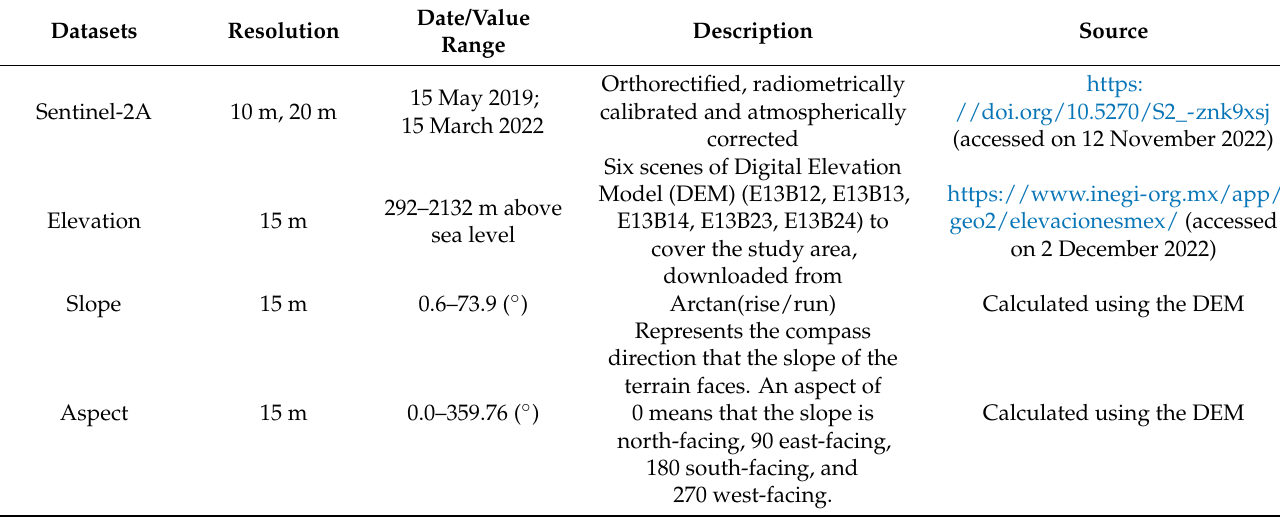
Table 1. Datasets Table 1. Datasets used.